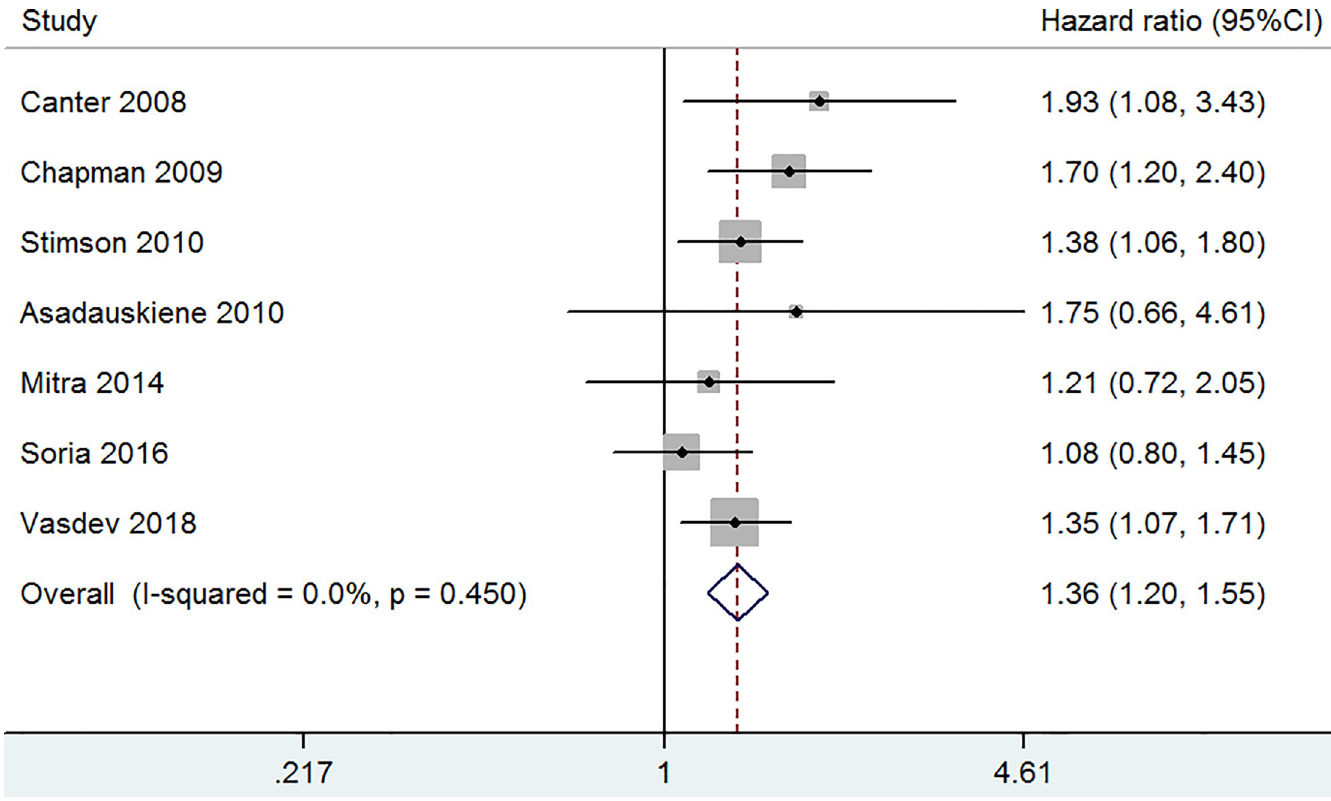
Fig 2. The hazard ratio (HR) of preoperative hydronephrosis associated with OS in bladder cancer patients.